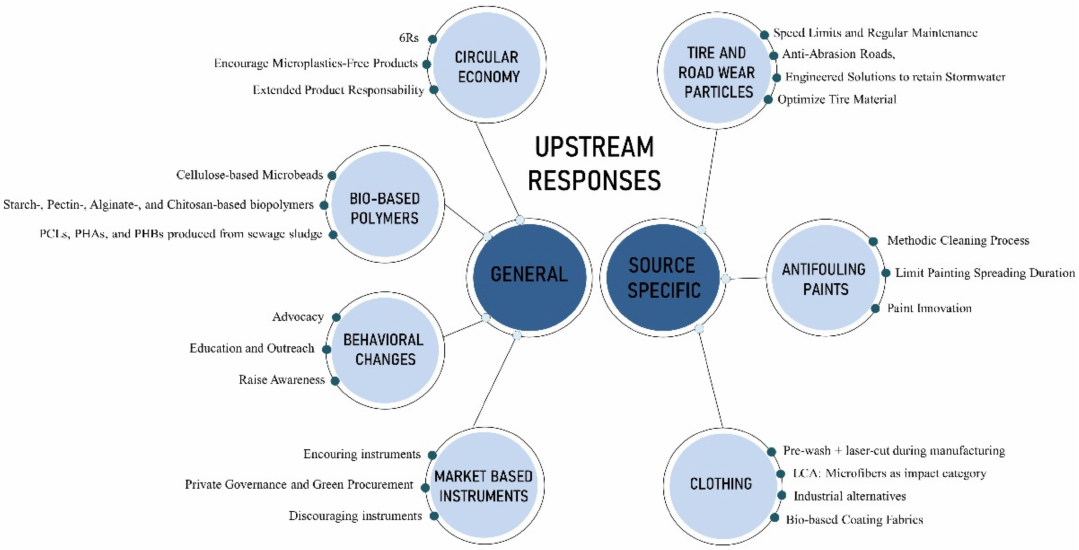
Figure 2. Upstream responses to prevent microplastic